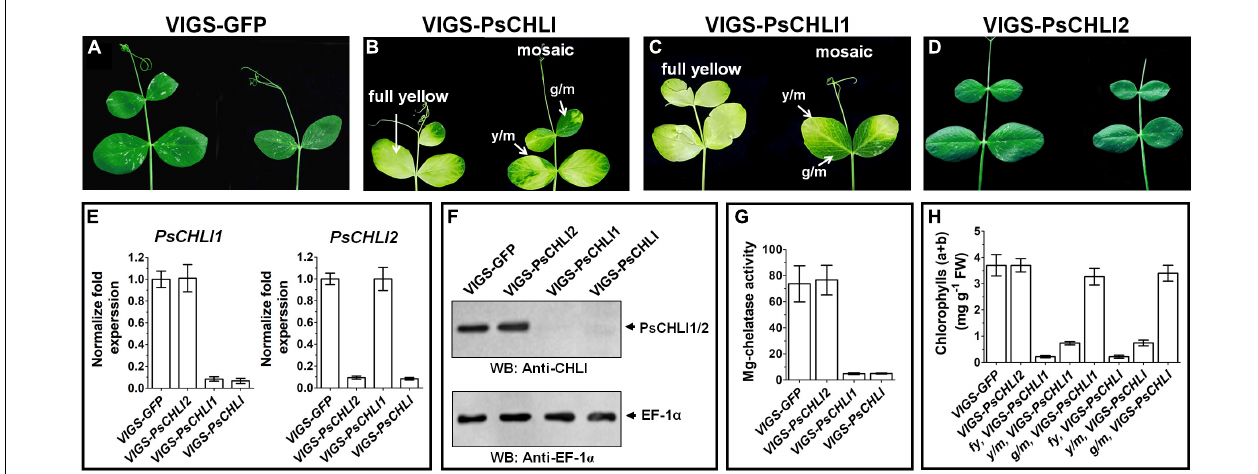
FIGURE 4 | Phenotypes of virus-induced gene silencing (VIGS) plants. PsCHLI1 and PsCHLI2 were silenced in pea by a VIGS method. VIGS-GFP plants represented a negative control for the effect of virus infection (A) . VIGS-PsCHLI plants, described in our previous study (Luo et al., 2013), were used as a positive control (B) . VIGS-PsCHLI1 plants showed yellow leaves. Three types of leaf phenotypes are shown: fully yellow leaves; y/m, yellow sectors from mosaic leaves; g/m, green sectors from mosaic leaves (C) . Leaves of VIGS-PsCHLI2 plants resembled those in VIGS-GFP control plants (D) . The expression of PsCHLI1 and PsCHLI2 in VIGS plants was measured by quantitative real-time PCR. The 2 − (cid:49)(cid:49) Ct method was used to calculate the relative expression. The transcript levels were quantitatively normalized to the transcript level of pea EF-1 α (E) . The protein level of PsCHLI1 and PsCHLI2 in VIGS plants was measured by western blot. EF-1 α was used as a loading control (F) . Mg-chelatase activity (G) and chlorophyll content (H) were also examined in VIGS plants. All plants had three independent infiltrations and were observed 3 weeks after infiltration. Error bars indicate the SEM from at least six VIGS plants in three independent